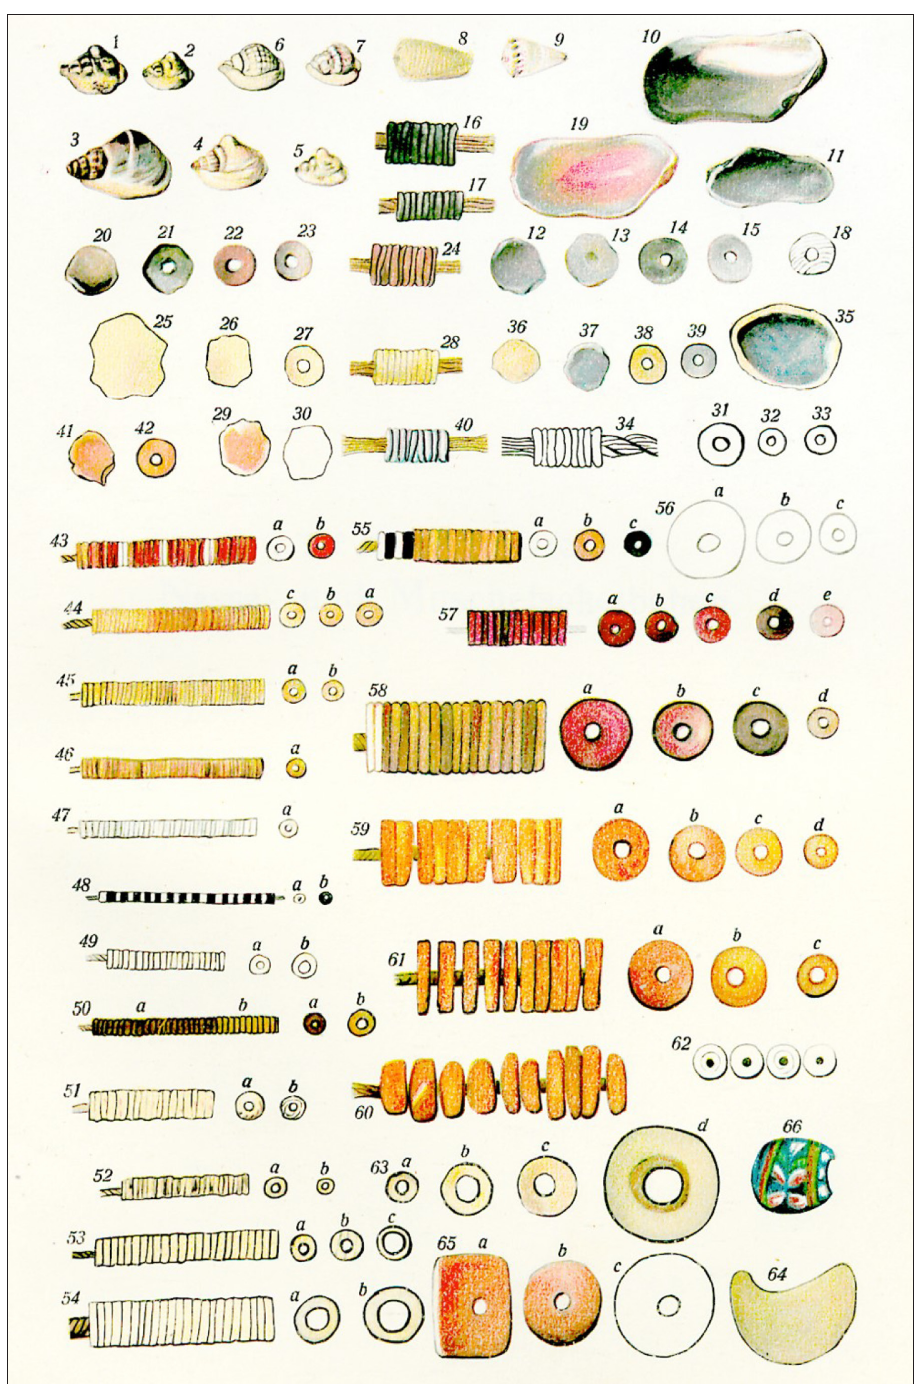
Figure 3: Diwara or tambu was just one variety among many natural currencies in a region in which one village’s money was considered jewelry by the next. This image shows different types of shell money from German New Guinea according to explorer Otto Finsch. Items 1-11, 19, 35 depict the species used to produce shell money. Items 1 & 2 show the species Nassa camelus (different ages), used for diwara in Blanche-Bucht, Neu-Pommern, and Deutsch-Neuguinea. Items 3, 4, 5 are Nassa bimaculosa (old, younger, young), used in the South Seas; Item 6 is Nassa callosa ; and item 7, Nassa callospira . Items 15-60 depict the finished product. For example: item 43 is “tapsoka,” the best variety of shell money in Neu-Mecklenburg; items 44, 45 are “arangit,” a second variety of shell money in Neu-Mecklenburg; item 46 is “kokonon luluai,” the cheapest variety used in Nusa and Neu-Mecklenburg. The paintings are by Anna Strohmeyer from Finsch, Südseearbeiten , plate I, figs.